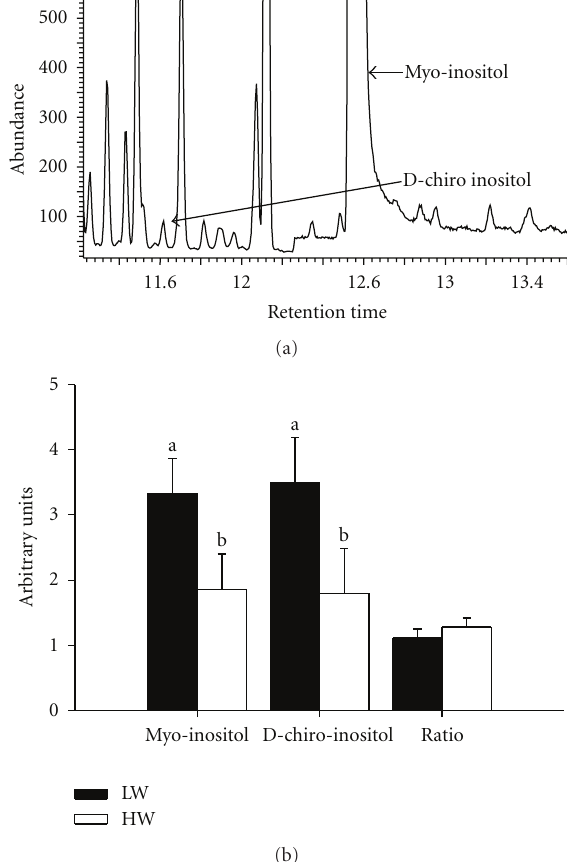
Figure 3: Myo-inositol and D-chiro-inositol levels in plasma from low birth weight (LW) and high birth weight (HW) piglets. (a) GC- MS spectra of a representative plasma sample. Peak at retention time 11.61 is D-chiro-inositol and peak at retention time 12.60 is myo- inositol. The spectra reveal the large di ff erence in concentration of D-chiro-inositol and myo-inositol in the plasma samples. (b) Arbitrary plasma inositol levels in LW and HW piglets, showing that LW piglets have a significantly higher plasma concentration of both myo- and D-chiro-inositol than HW piglets at birth. Each bar represents the LSMeans of 12 piglets ± SEM. ab, P < . 05 . Bars named ratio is representing the ratio between D-chiro-inositol and